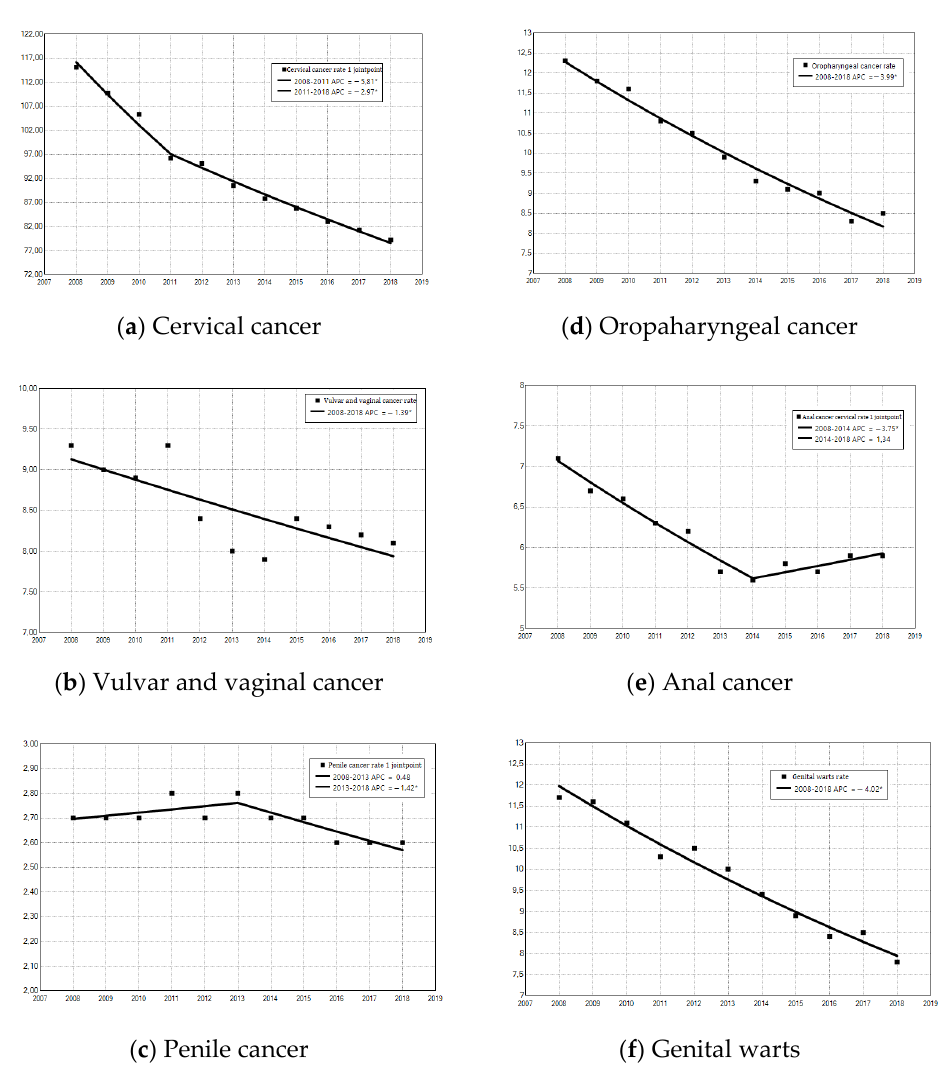
Figure 1. Annual percentage change (APC) of hospitalization due to HPV-related diseases: ( a ) cervical cancer, ( b ) vulval and vaginal cancer, ( c ) penile cancer, ( d ) oropharyngeal cancer, ( e ) anal cancer, and ( f ) genital warts. * APC significantly different from 0 at the α = 0.05 level